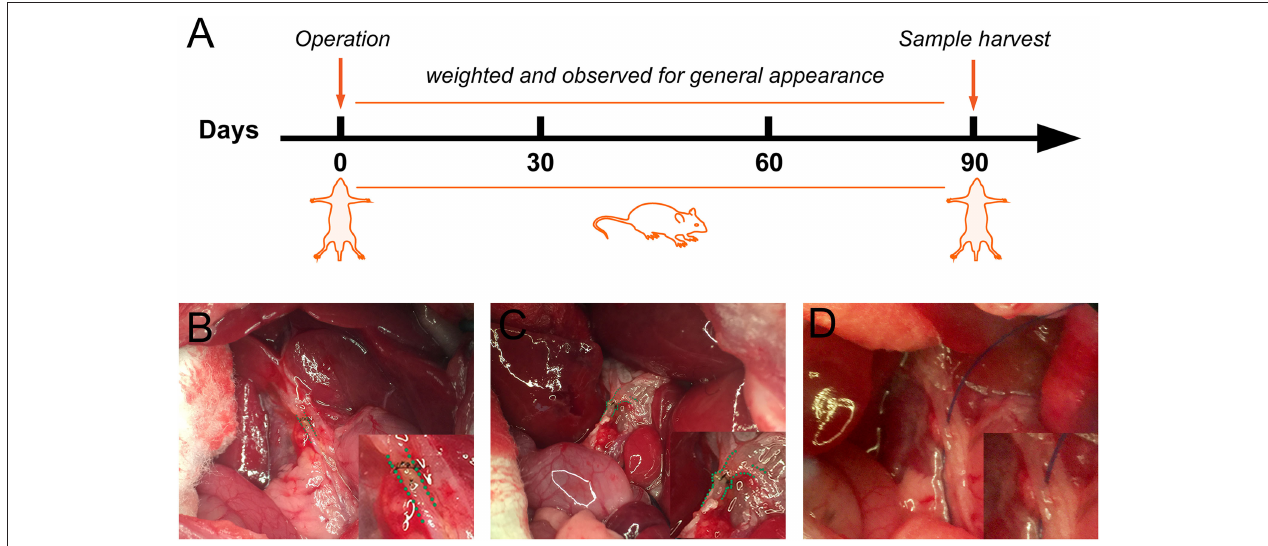
FIGURE 1 | Schematic representation of the experimental procedure and anastomosis methods for bile duct injured rats. (A) The flowchart of rat experiment. (B) Traditional biliary anastomosis in the control group. Common bile duct after an end-to-end suture was highlighted by a green dashed line. (C) “Fish-mouth to fish mouth” anastomosis was done in the fish mouth shaped (FMS) group. The highlighted common bile duct was reconstructed by a wider anastomosis. (D) The common bile duct was isolated in the sham